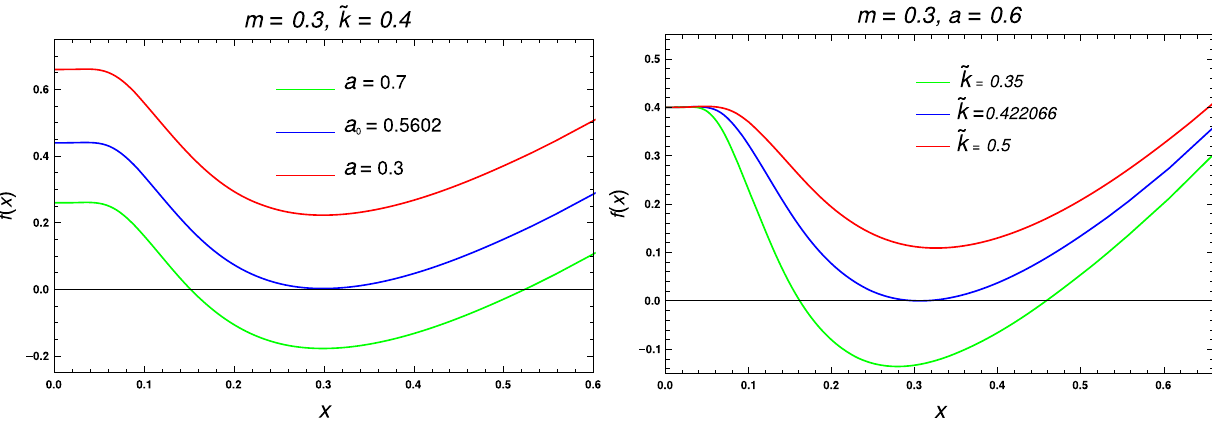
Fig. 3 The metric function f ( x ) vs x showing extremal black hole with degenerate horizon for a = a 0 = 0 . 5602 (left) and ˜ k = ˜ k 0 = 0 . 42206 (right) and the black hole with Cauchy and event horizons exist for a > a 0 and ˜ k < ˜ k